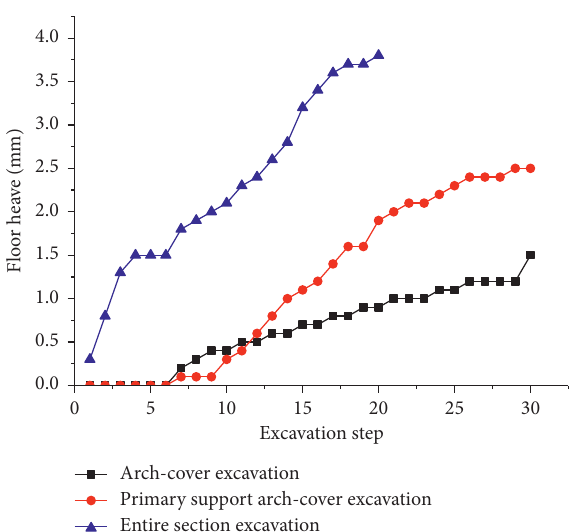
Figure 18: Floor heave curves with sustainable